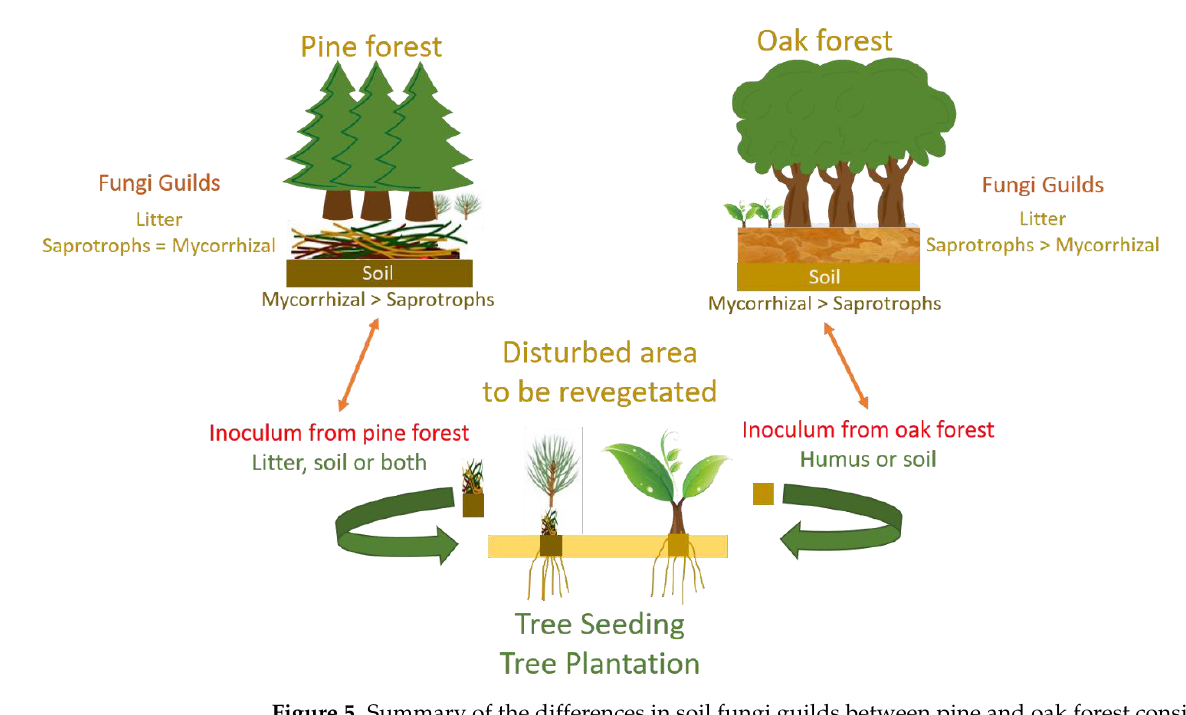
Figure 5. Summary of the differences in soil fungi guilds between pine and oak forest considering three soil layers. The possible types of inoculums to be used in restoration frameworks that maintain the most important fungi for pine and oak trees are shown. Litter, soil or mixed inoculum is recommended for pine and use of soil or humus is recommended for oak. Adequate inoculum might accelerate the man-induced tree seedling establishment process.